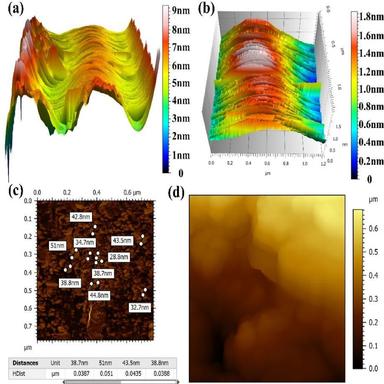
AFM scanning analysis of oil shale samples obtained via mechanical stripping. (a)e(b) Anisotropic distributions of organic matter at a scale of several nanometers. (c)e(d) Anisotropic distribution of organic matter at a scale of tens of nanometers.